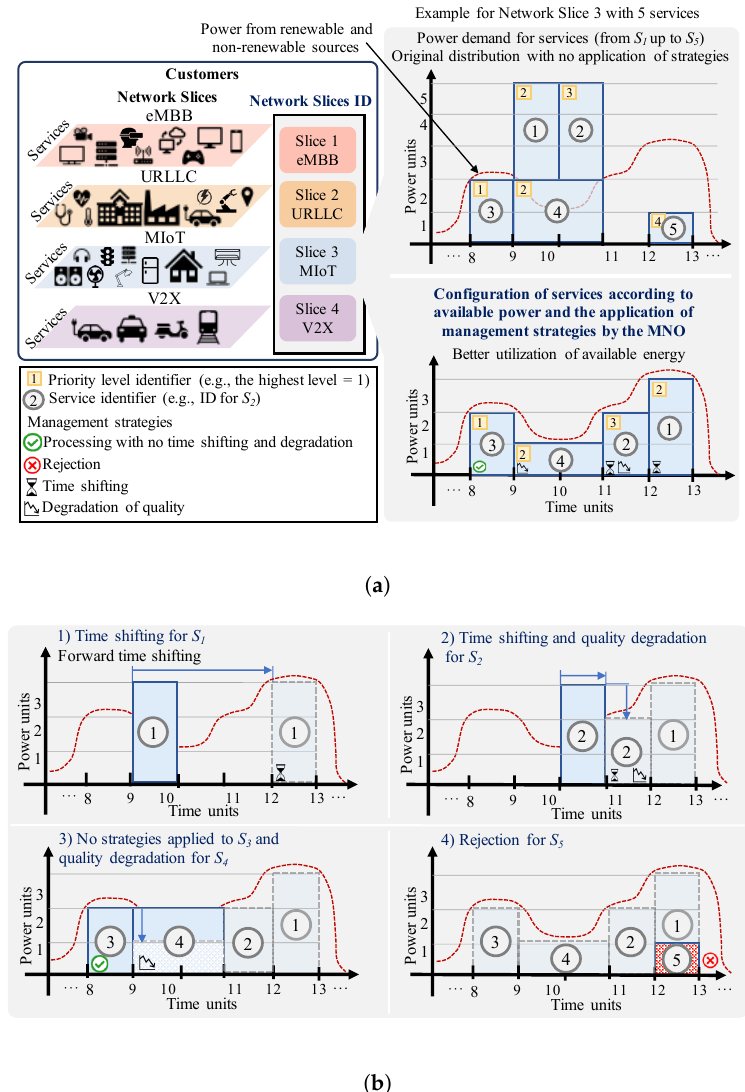
Figure 1. Example of application of the management strategies for adaptive energy management in 5G network slicing. ( a ) Application of management strategies for the network slice 3. In this example, the initial distribution of services (initial time, duration, and power demanded) causes inefficient use of energy and allows the execution of only two services ( S 3 and S 5 ). The use of management strategies instead allows optimization in the consumption and processing of four services ( S 1 , S 2 , S 3 , and S 4 ). ( b ) Disaggregated representation of the management strategies applied to services belonging to network slice